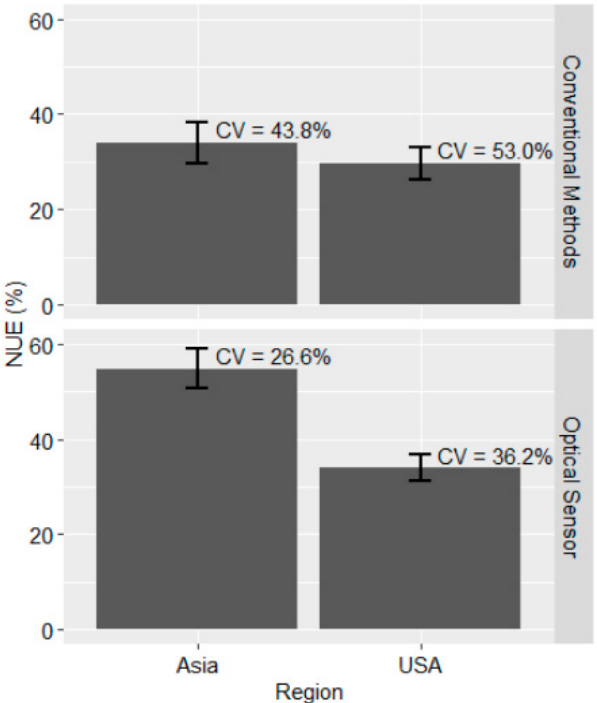
Figure 1. NUE for optical sensor and conventional methods of N management for the U.S. and Asia. The error bar indicates standard error, while CV represents coefficient of variation.